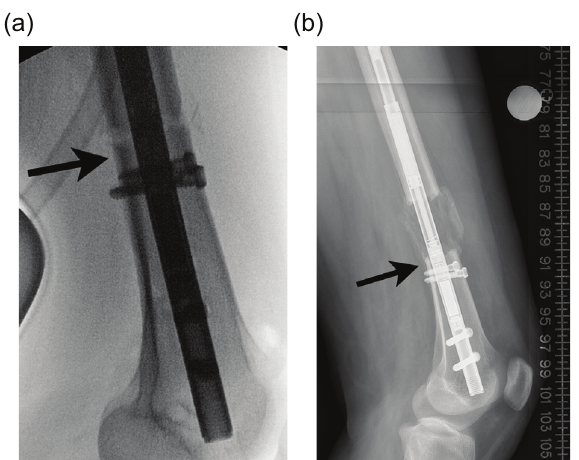
Figure 9. (a) The intraop fluoroscopy image shows contact of the posterior cortex of the distal fragment with the ILN at the osteotomy site (arrow). (b) After 5 cm of lengthening the distal fragment has not been able to flex due to the cortical abutment